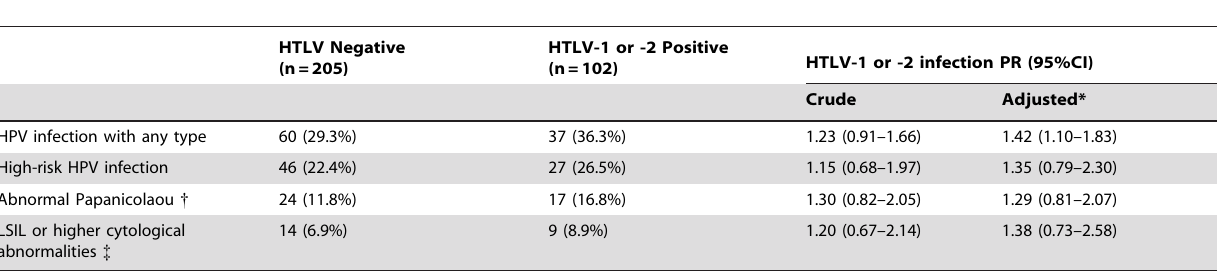
Table 2. Association between HTLV-1 or -2 infection and HPV infection and cytological abnormalities in women from the Shipibo- Konibo ethnic